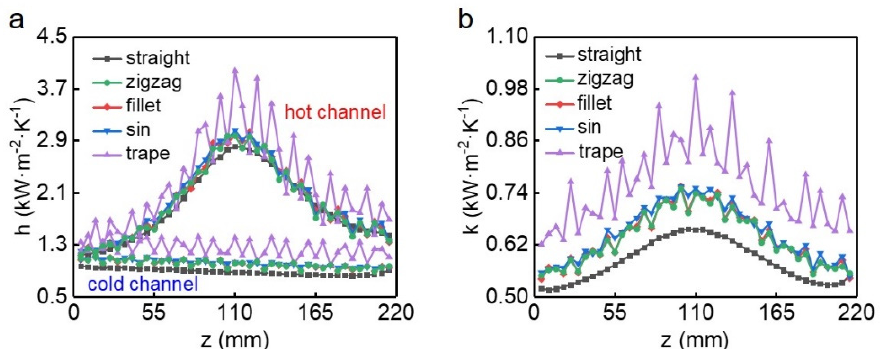
Figure 7. The distribution of ( a ) Local convective heat transfer coefficient h and ( b ) Local heat transfer coefficient k on both hot and cold sides along the flow direction in the five channels.